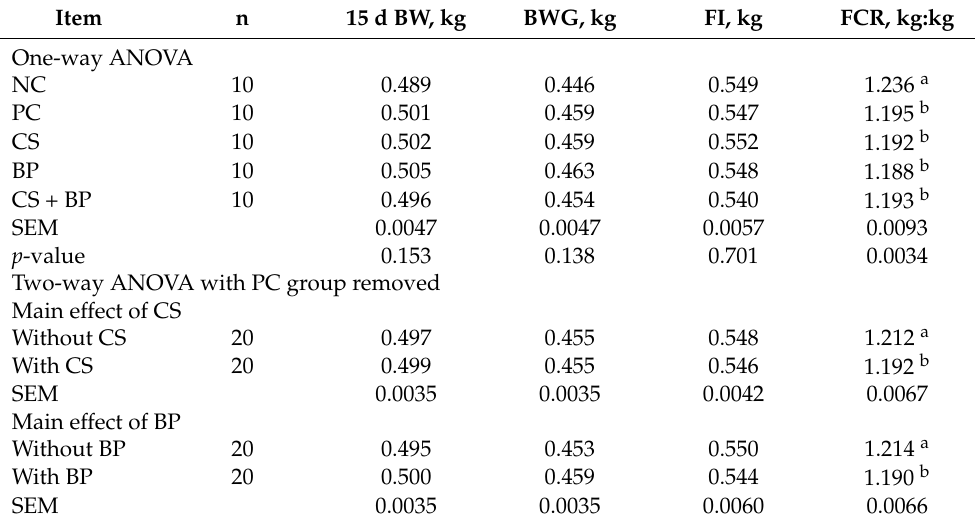
Table 2. Live performance of broilers fed diets with and without bacitracin methylene disalicylate or various antibiotic alternatives from 0 to 15 d post-hatch 1